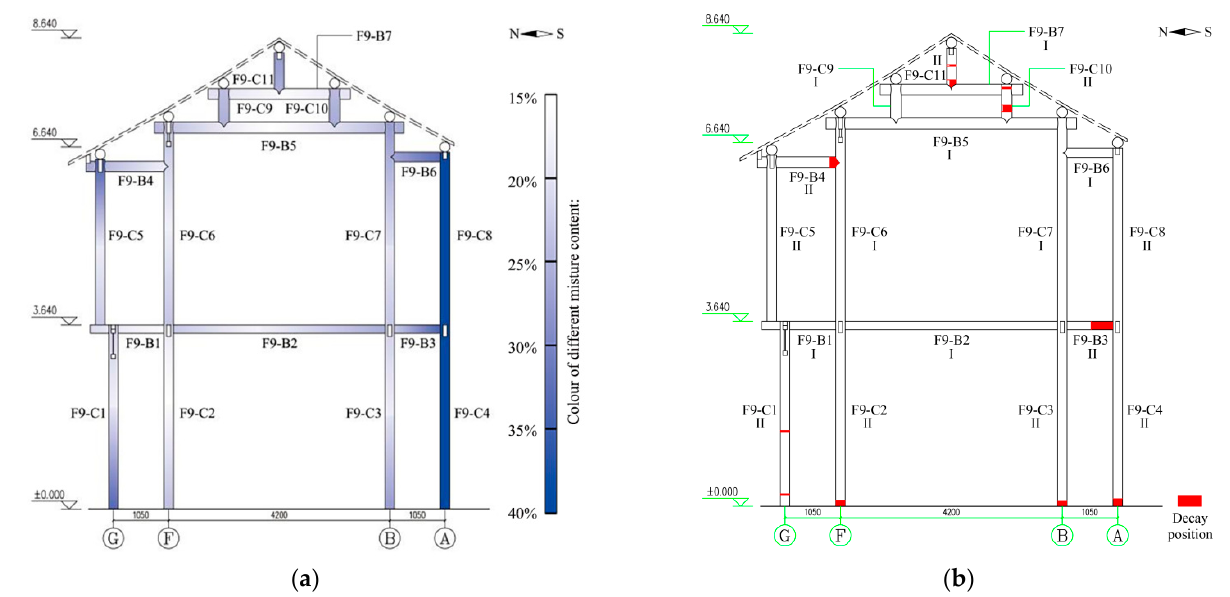
Figure 20. Moisture content and decay of F9 in Fujiu Zhou house; ( a ) schematic diagram of moisture content; ( b ) schematic diagram of decay position and decay grade.